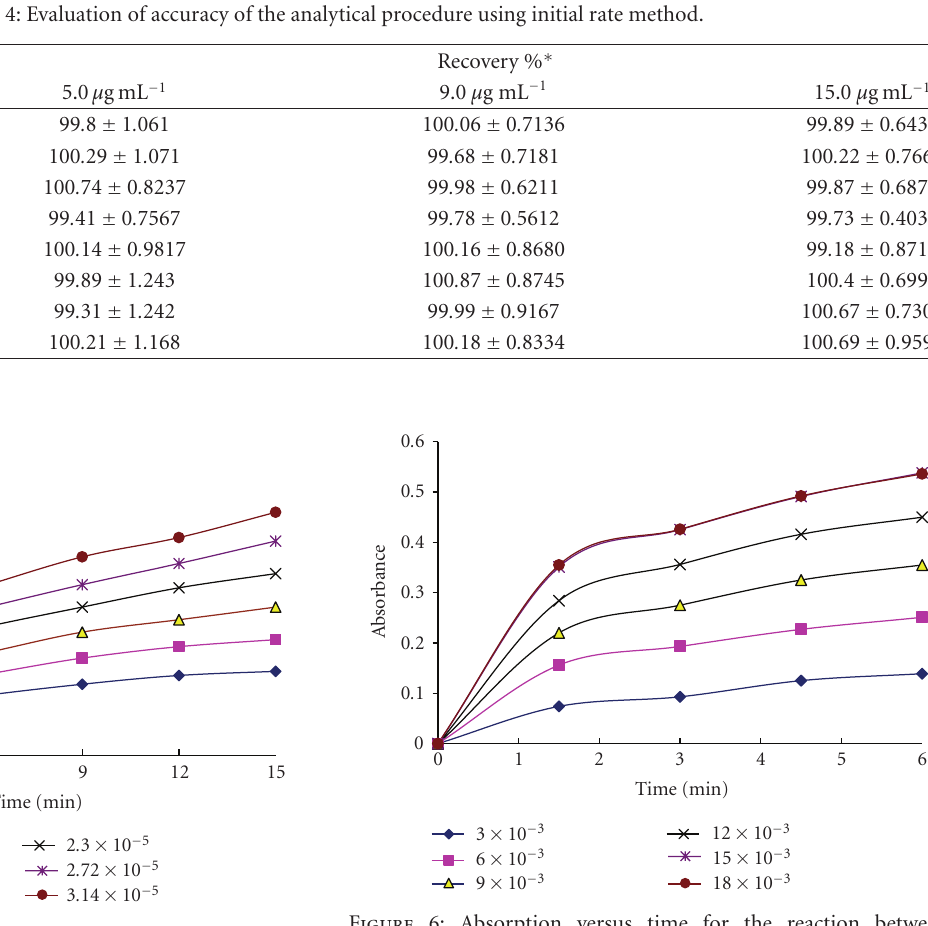
Figure 5: Absorption versus time for the reaction between cefotaxime (di ff erent molar concentrations) and KMnO 4 (1 . 8 × 10 − 3 molL − 1 ).